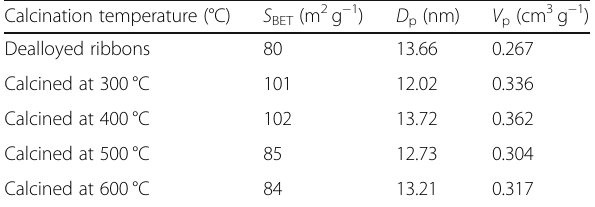
Table 1 Specific surface area ( S BET ), pore size ( D p ) and